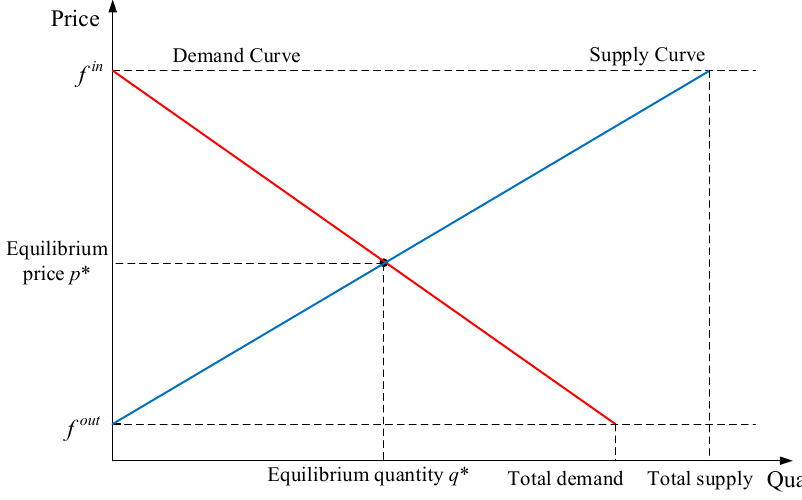
Figure 1. Linear approximations of the demand and supply curves.